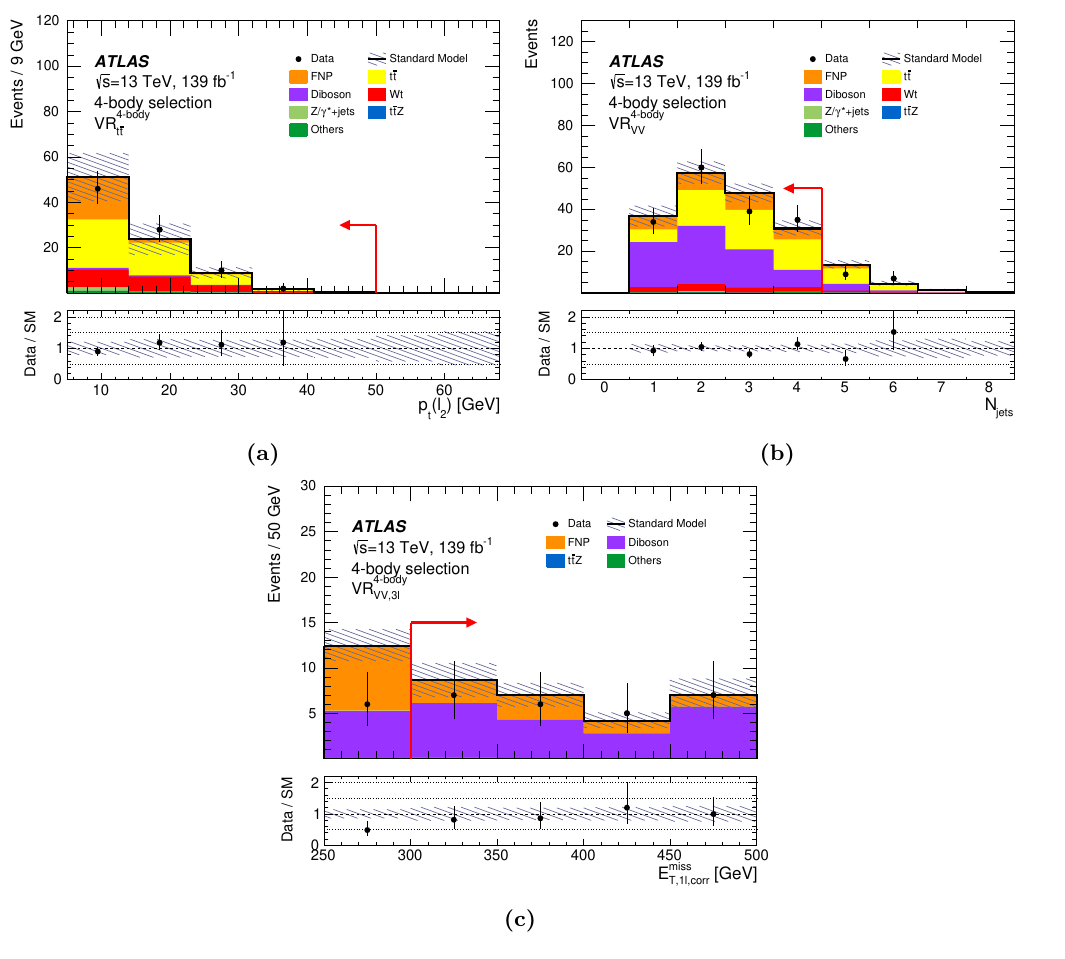
Figure 7 . Four-body selection. Distributions of (a) p ( ‘ ) in VR 4-body , (b) n in VR 4-body and T 2 jets V V tt (c) E miss in VR 4-body after the background fit. The contributions from all SM backgrounds are T , 1 ‘, corr V V, 3 ‘ shown as a histogram stack. “Others” includes contributions from V V V , tt t , tttt , tt W , tt WW , tt WZ , tt H , and tZ processes. The hatched bands represent the total statistical and detector-related systematic uncertainty. The rightmost bin of each plot includes overflow events. In the upper panels, red arrows indicate the validation region selection criteria. The bottom panels show the ratio of the observed data to the total SM background prediction, with hatched bands representing the total uncertainty in the background